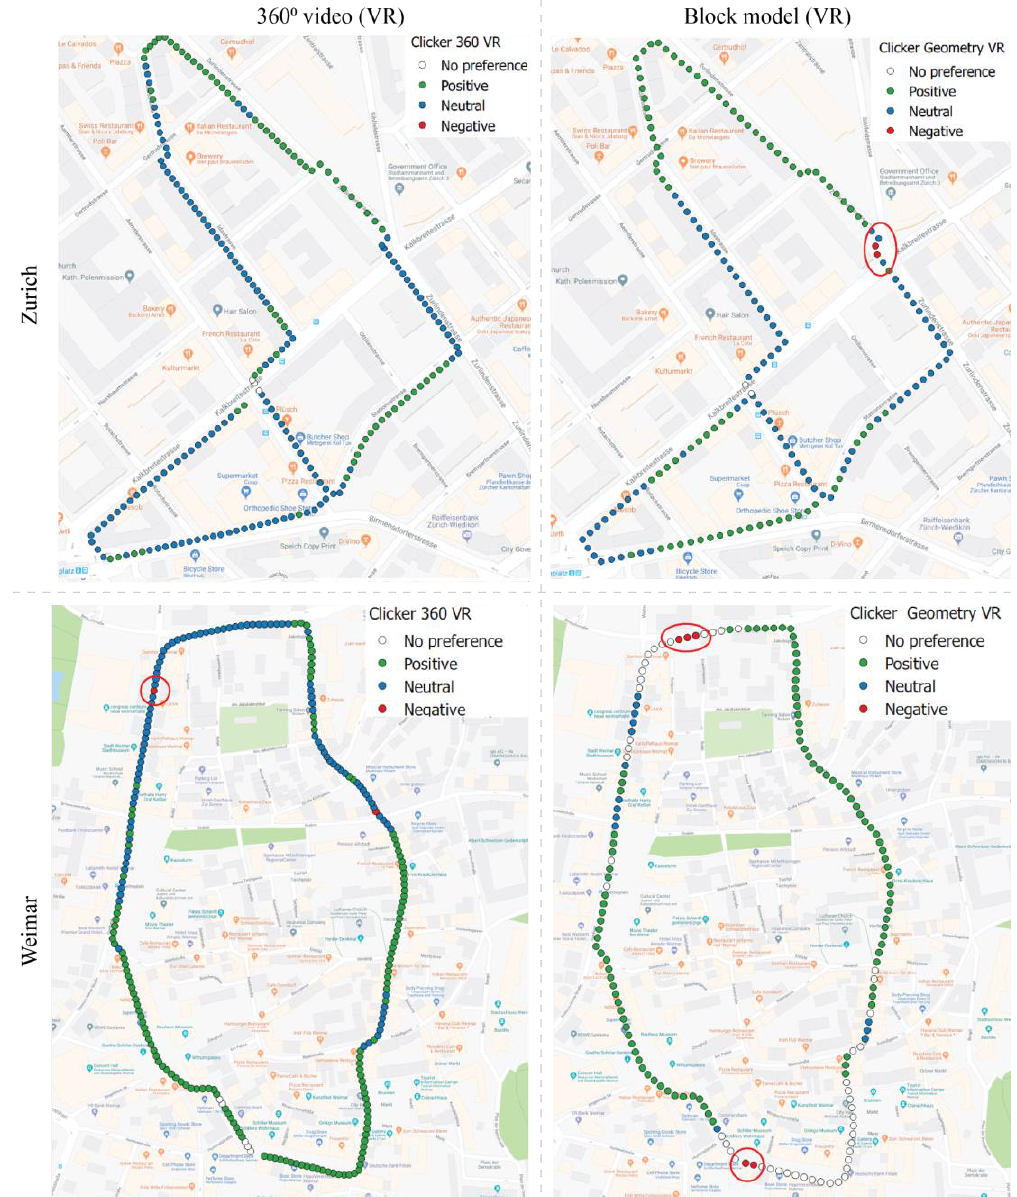
Figure 9. Results from the virtual-reality studies: Subjective environmental appraisal, mapped along the two experimental paths in the 360° video (left) and block model (right), for Zürich (above) and Weimar (below). The red areas indicate negative ratings, which are surprisingly few in the virtual setting; and absent in the Zurich evaluation. The heading clicker refers to the way participants evaluated the environment, pressing the buttons like, neutral, or dislike continuously during the virtual video presentation.